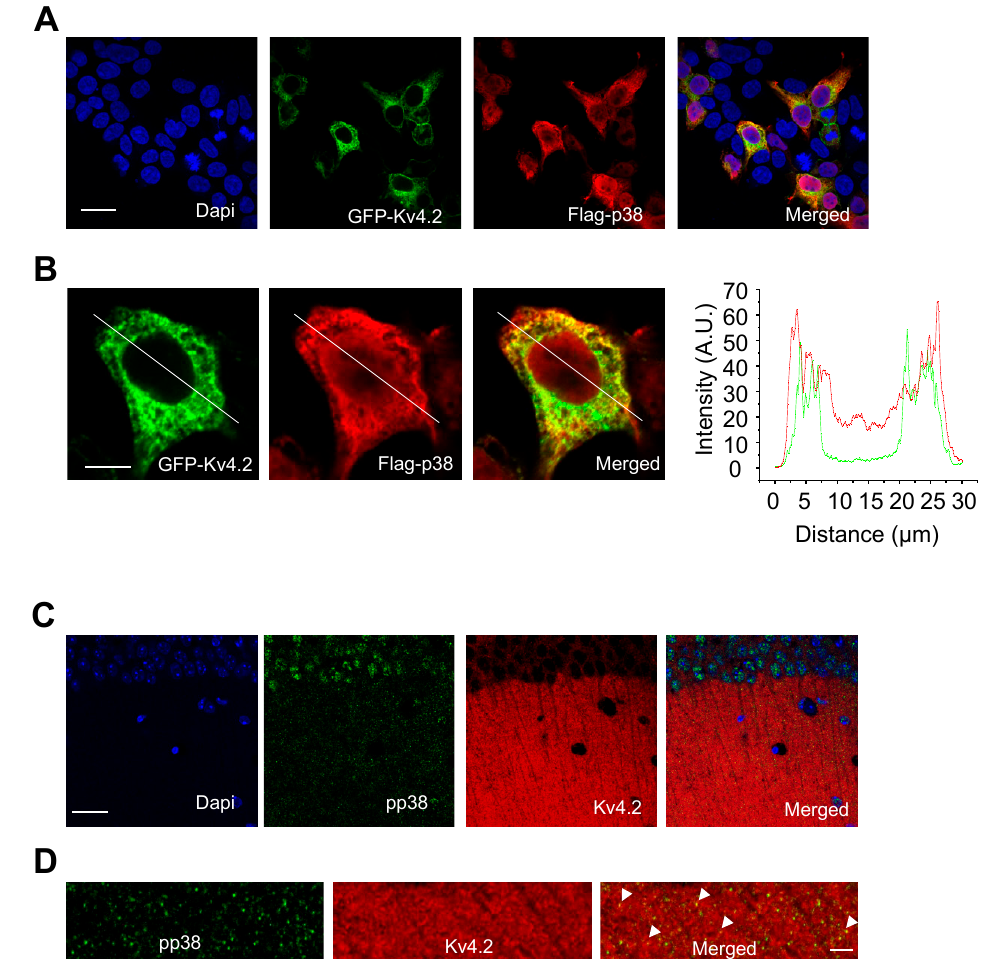
Figure 4. p38 MAPK colocalizes with Kv4.2. ( A ) HEK293T cells were transfected with GFP-Kv4.2 and Flag-p38. Cells were fixed and stained with GFP and Flag to show co-localization. Scale bar: 20 μ m. ( B ) High magnification images and line scan analysis of colocalization. Scale bar: 5 μ m. ( C ) Mouse brains were co-stained with Kv4.2 and pp38 antibody. Phosphorylated p38 is localized in the cell body and dendrites as well. Scale bar: 20 μ m. ( D ) High magnification images showing Kv4.2 and pp38 colocalized in dendrites, as indicated with arrow heads. Scale bar: 5 μ m.